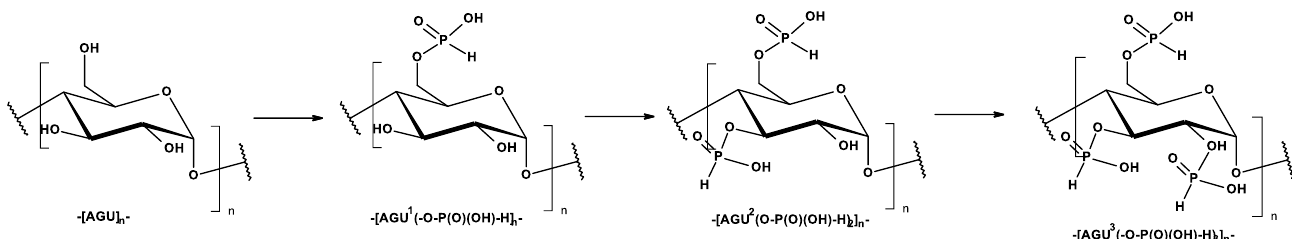
Figure 3. Gradual phosphorylation of cellulose (AGU m = AGU units deprived m(OH) ( m = 1 – 3) functions; ─ [AGU 1 (- O - 2 (- O -P(O)(OH)-H) 3 -( O -P(O)(OH)-H) 2 ] n –, DS = 2; – [AGU 3 ] n –, DS = P(O)(OH)-H)] n ─ , DS = 1; ─ [AGU 2 (- O -P(O)(OH)-H) 2 ] n ─ , DS = 2; ─ [AGU 3 -( O -P(O)(OH)-H) 3 ] n ─ , DS = 3). P(O)(OH)-H)] n –, DS = 1; –[AGU